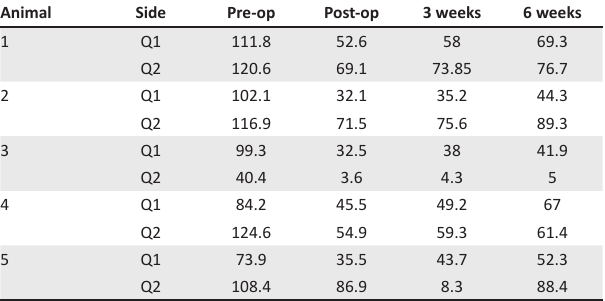
TABLE 2: Average grey scale values for the left and right maxilla of each animal. Animal Side Pre-op